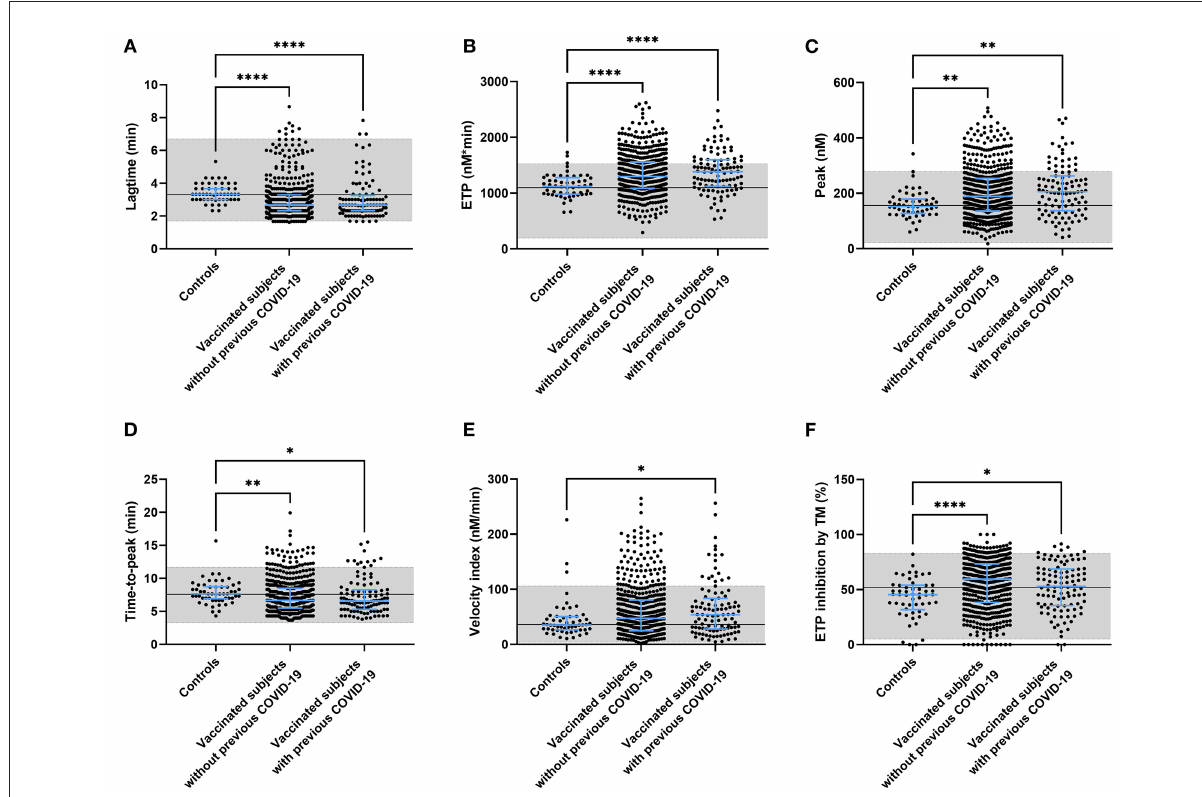
FIGURE3 Thrombin generation parameters in controls and subjects vaccinated with ChAdOx1-S with and without prior COVID-19 infection. Thrombin generation was measured at 5 pM tissue factor and the lag time (A) , ETP (B) , peak height (C) , time-to-peak (D) , velocity index (E) , and the inhibition of the ETP by the addition of thrombomodulin (F) were quantified. Reference values for each parameter are indicated as the gray area in the dot plot. Differences between the groups were analyzed by ANOVA or Kruskal-Wallis analysis, depending on the distribution of the data. P -values below 0.05, 0.01, 0.001, and 0.0001 were marked as * , ** , *** , and **** ,